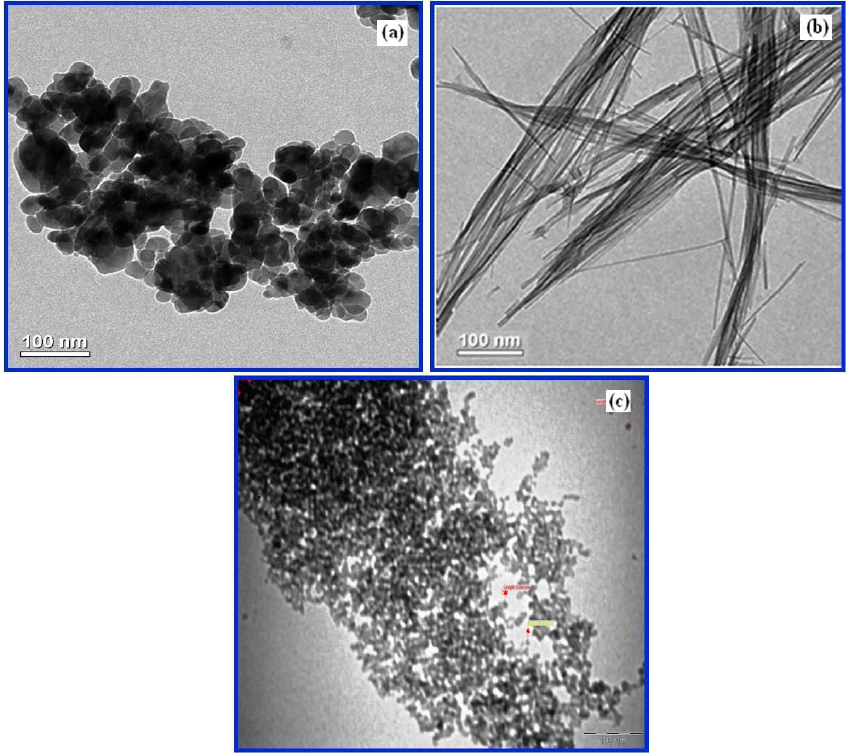
Figure 4. TEM images of γ -Fe 2 O 3 nanostructures synthesized using different % (1%, 2% and 3%) of AV extract ( a ) nanoparticle aggregates ( b ) nanobelts and ( c ) nanodots, respectively.